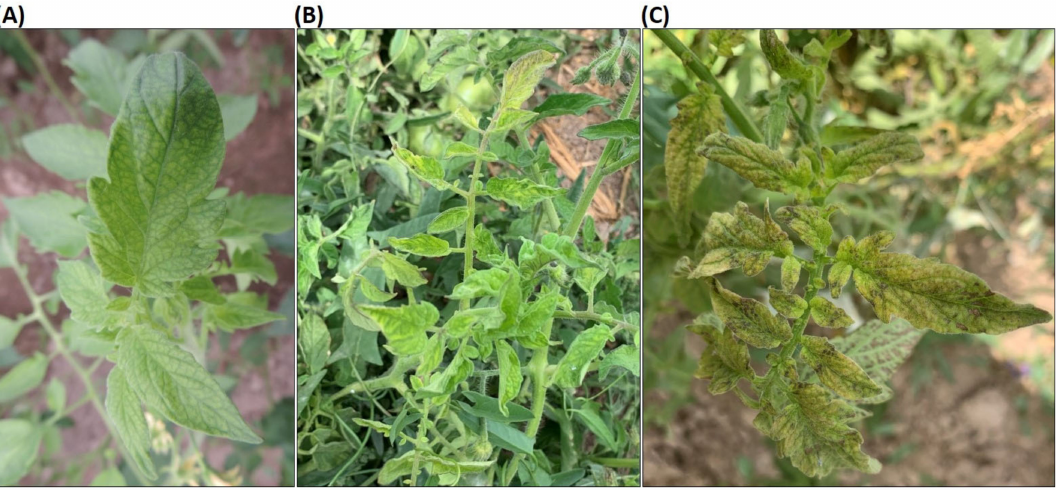
Figure 3. Symptoms caused by viral diseases in tomato samples. ( A ) shows a plant only infected with CMV, while ( B , C ) are different plants infected with CMV and